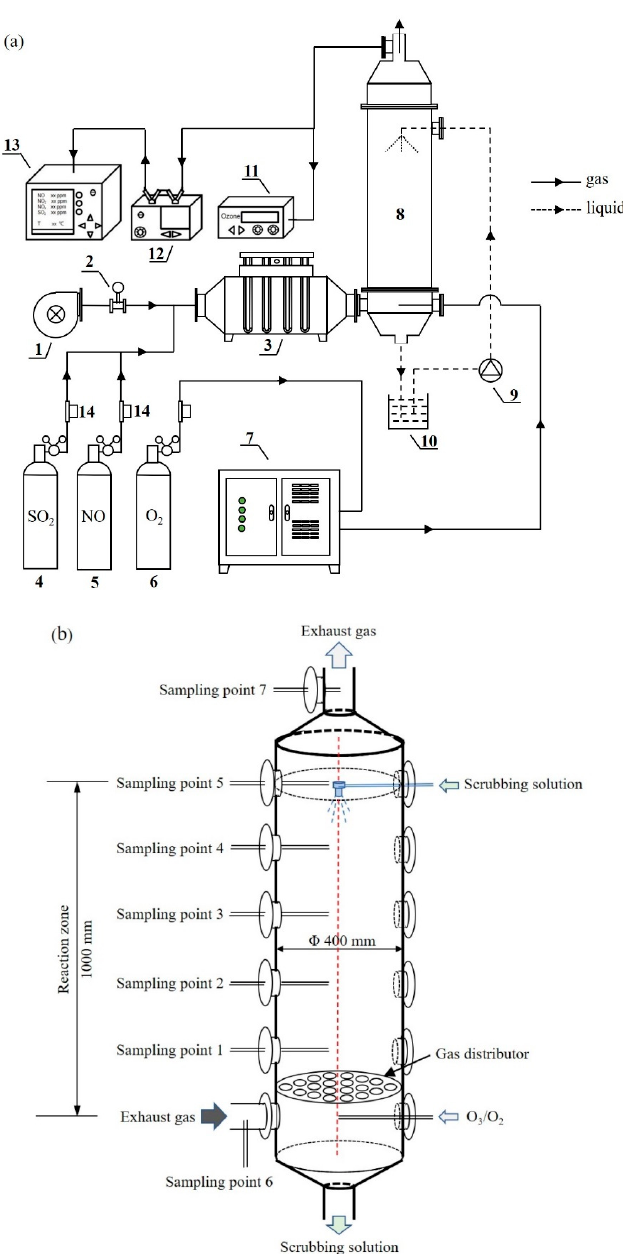
Figure 2. ( a ) Schematic diagram of our experimental setup: 1: variable frequency air blower; 2: vortex flow meter; 3: air heater; 4–6: gas cylinders; 7: ozone generator; 8: reactor; 9: circulating pump; 10: solution tank; 11: ozone monitor; 12: electrical condenser; 13: gas analyzer; 14: mass flow meters. ( b ) Schematic diagram of the